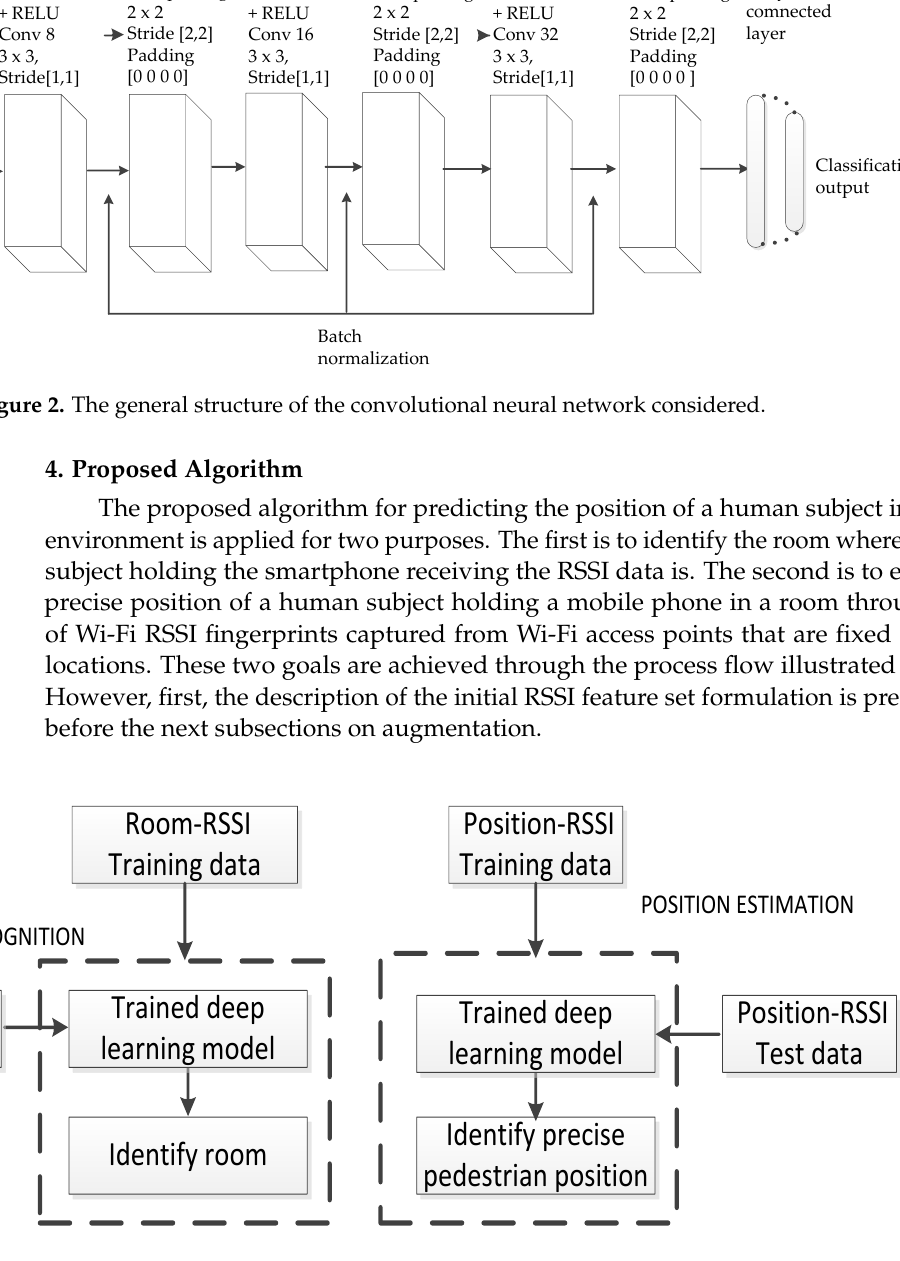
Figure 3. Model of the